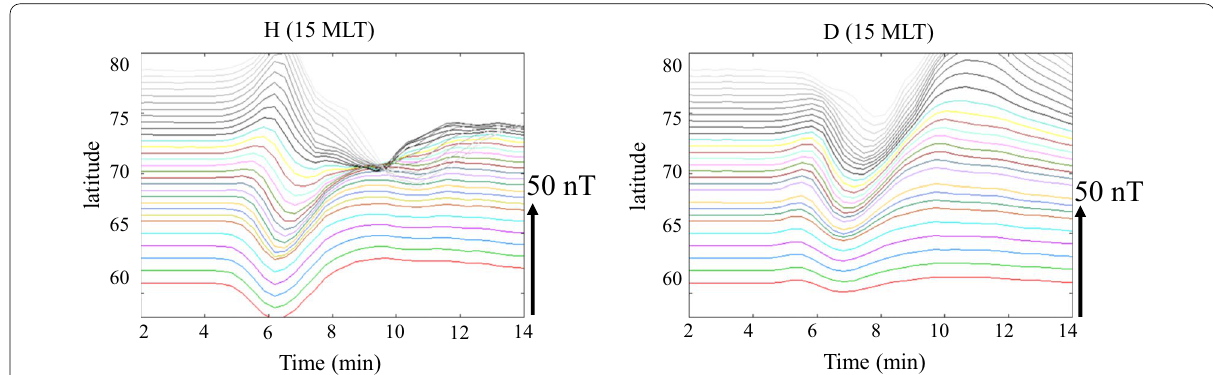
Fig. 1 Latitudinal dependences of the temporal variations of the H- and D-component ground magnetic fields associated with the SC in the latitudes from 60.8° to 78.5° in the northern hemisphere at 15 MLT. The vertical arrow in the right axis in each panel indicates the magnetic variation